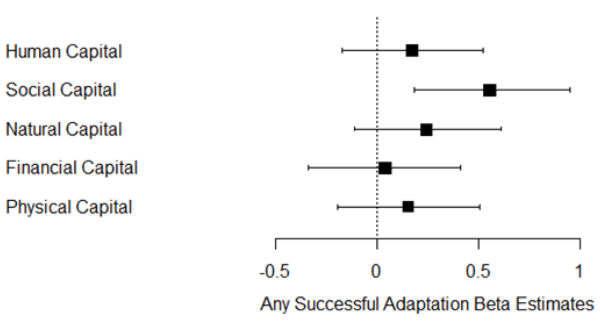
Fig. 5. Plot showing the model-averaged beta estimates for each type of capital for the probability of having any successful